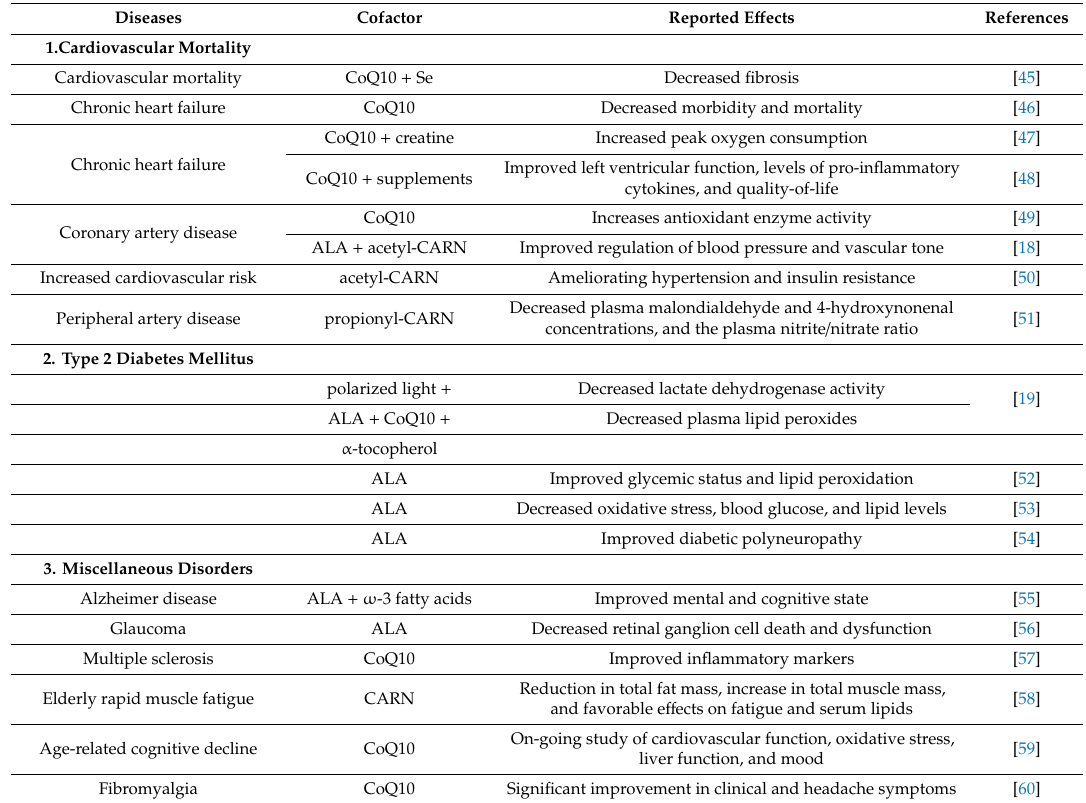
Selected clinical studies testing the e ff ects of ALA, CoQ10, or (acyl-) CARN in aging-related